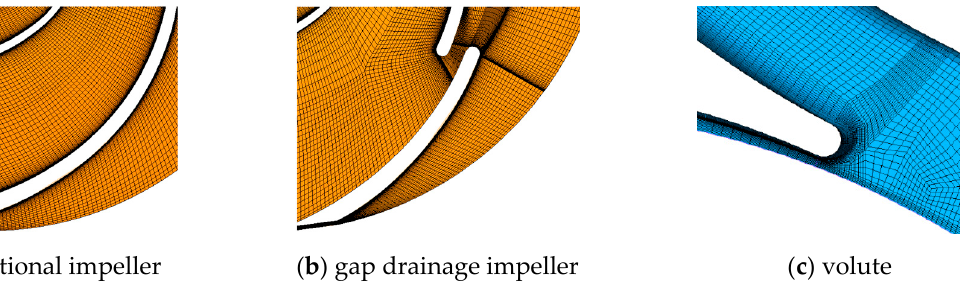
Figure 4. Grid division of the computing domain.